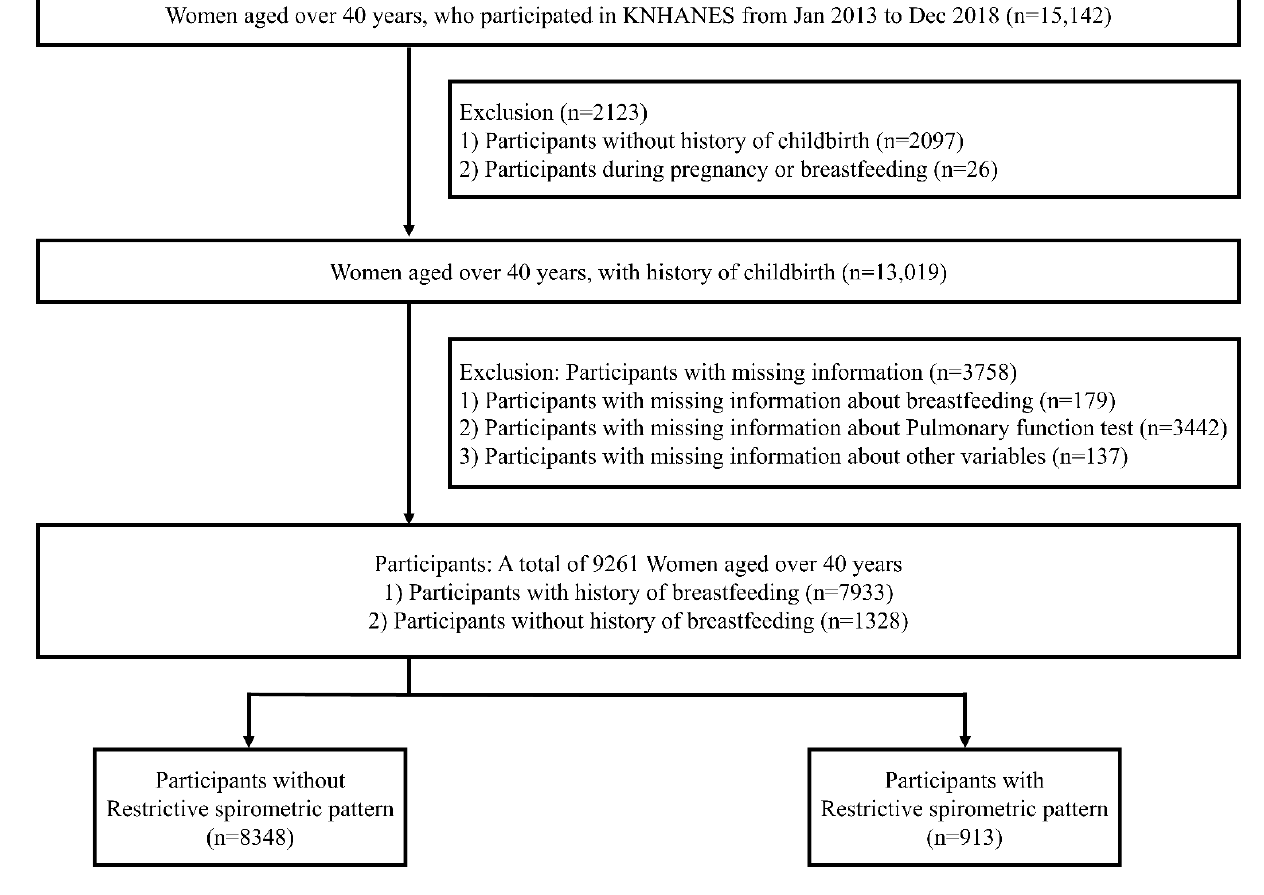
Figure 1. Flow chart of study population selection.